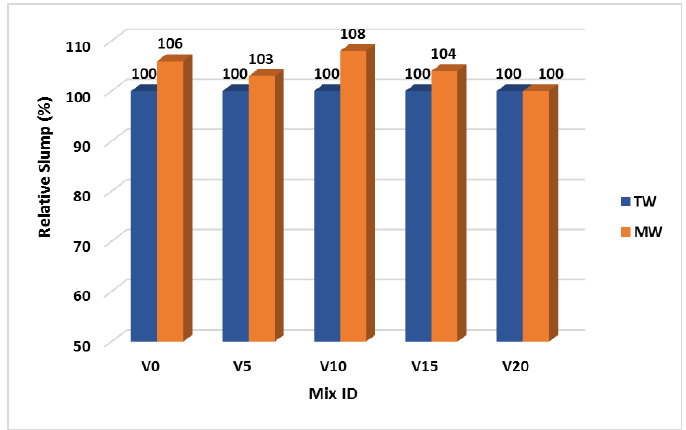
Figure 8. Effect of magnetized water on volcanic concrete slump.